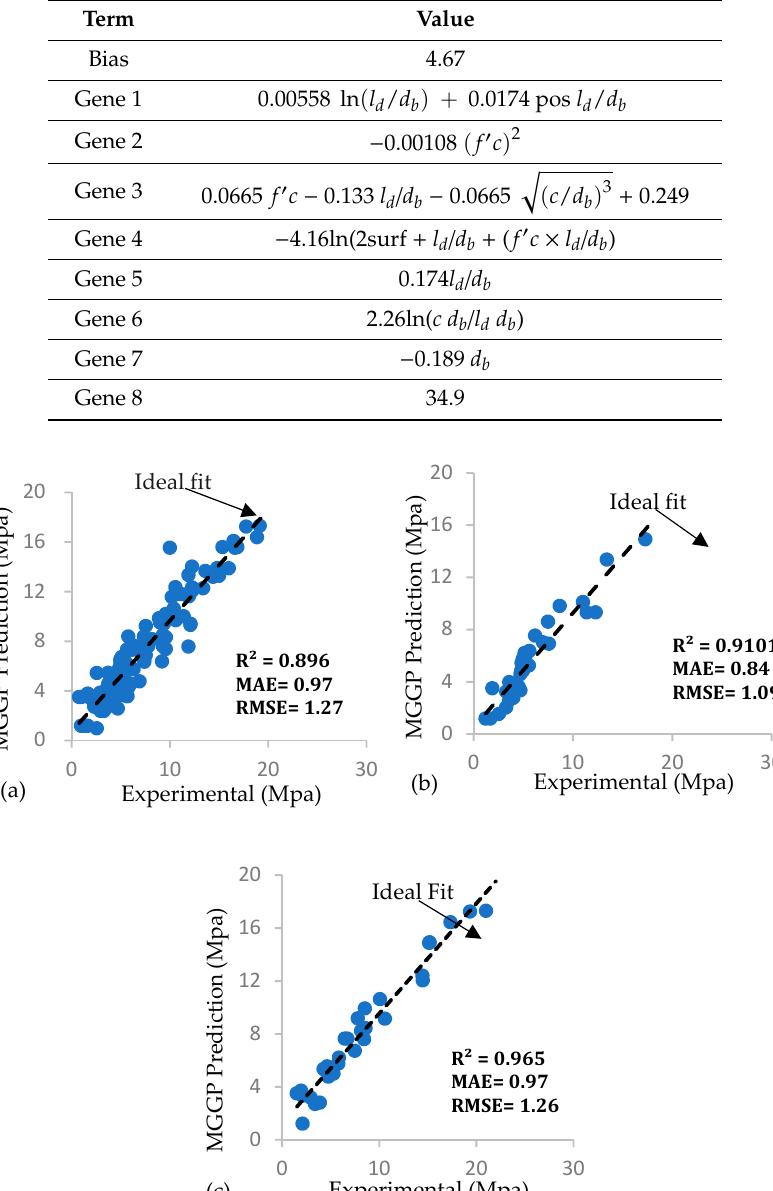
Table 3. Individual genes in the MGGP model.